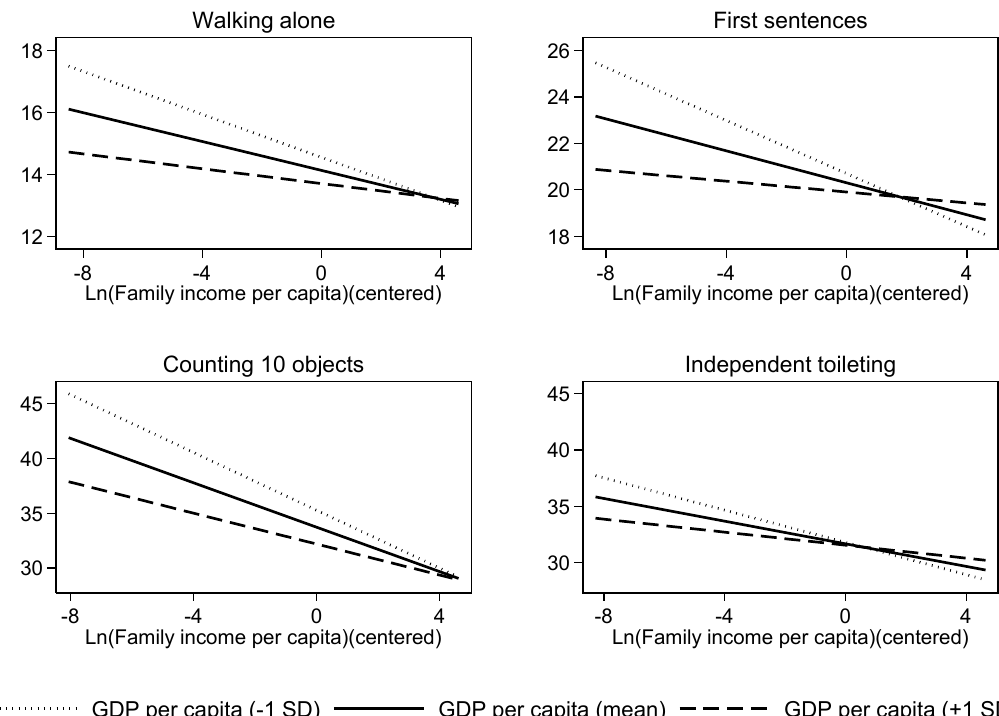
Figure A2. Predicted age of attainment of development milestones with family income as a function of county-level GDP per capita.